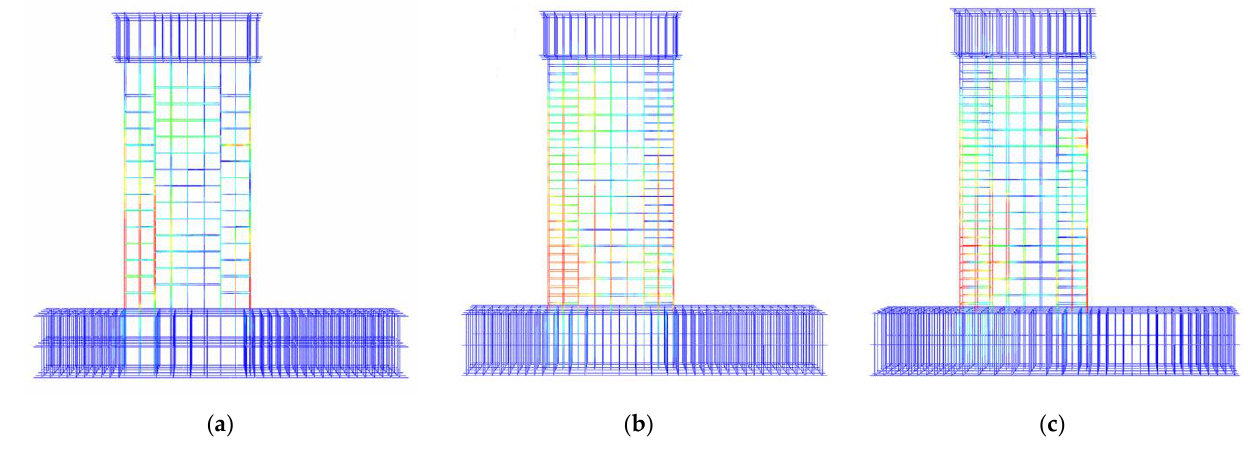
Figure 32. Failure patterns of steel bars of three numerical models. ( a ) CS-1; ( b ) CS-2; ( c )